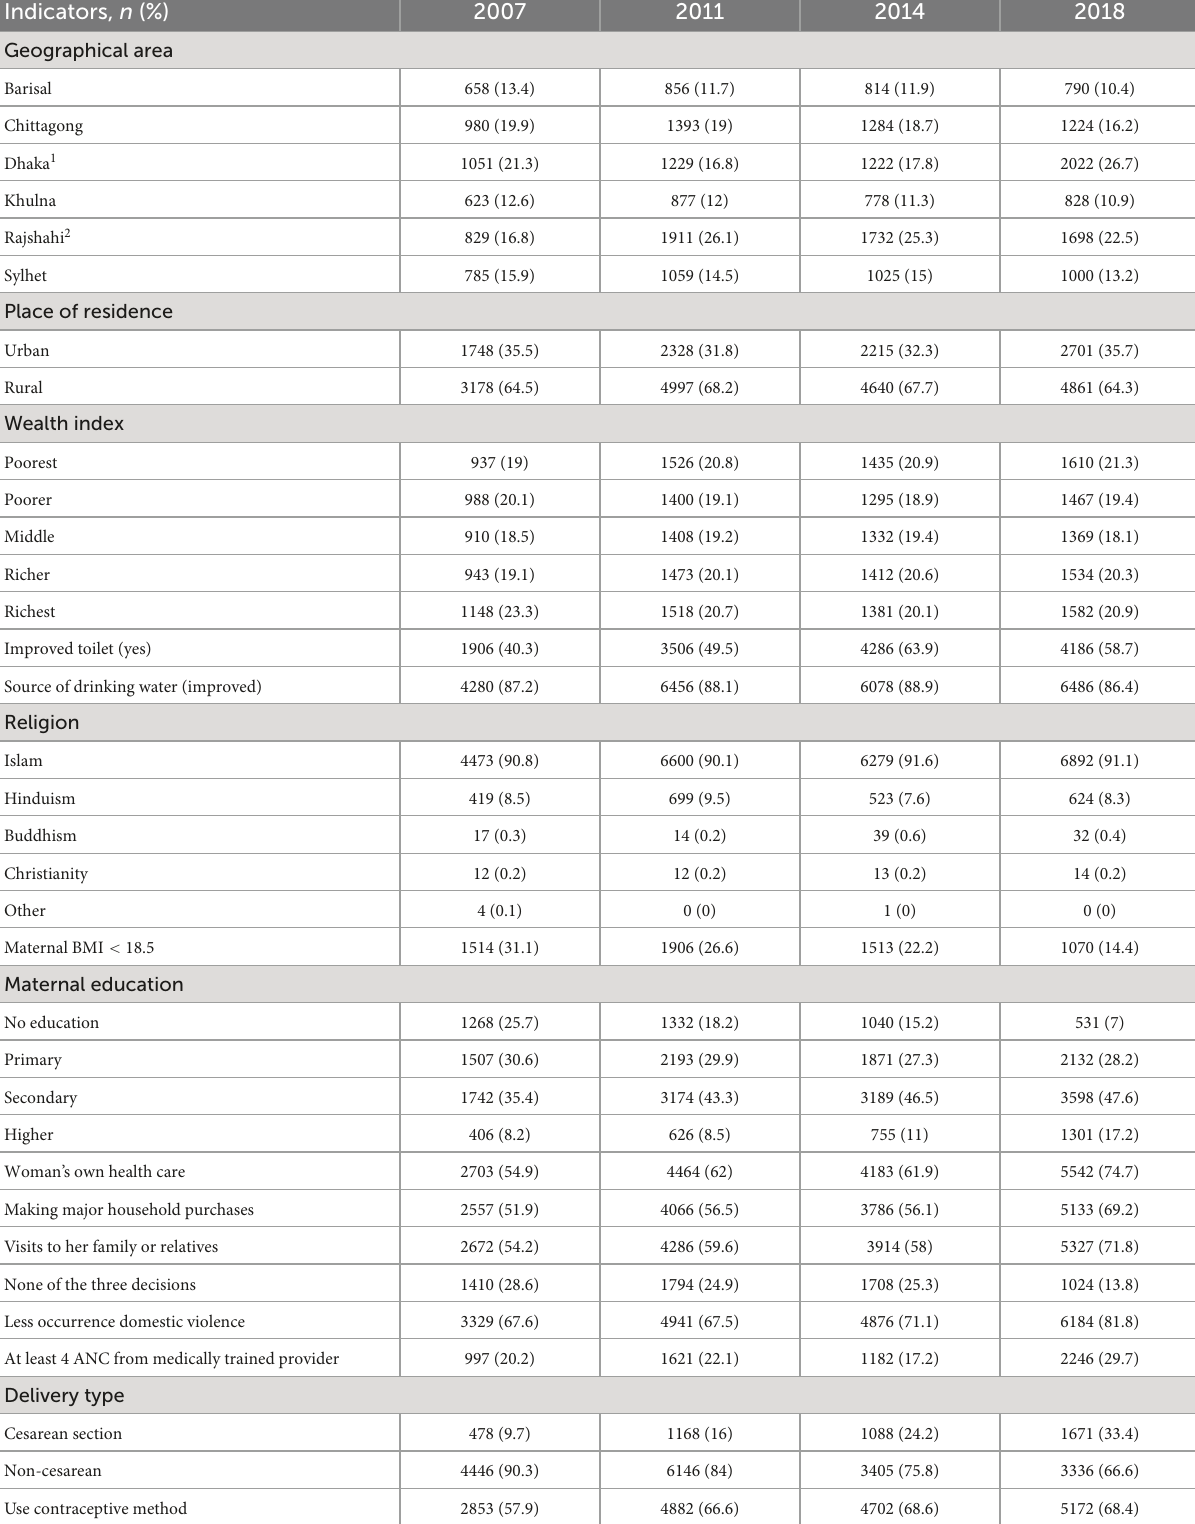
TABLE 1 General characteristics of households by survey time